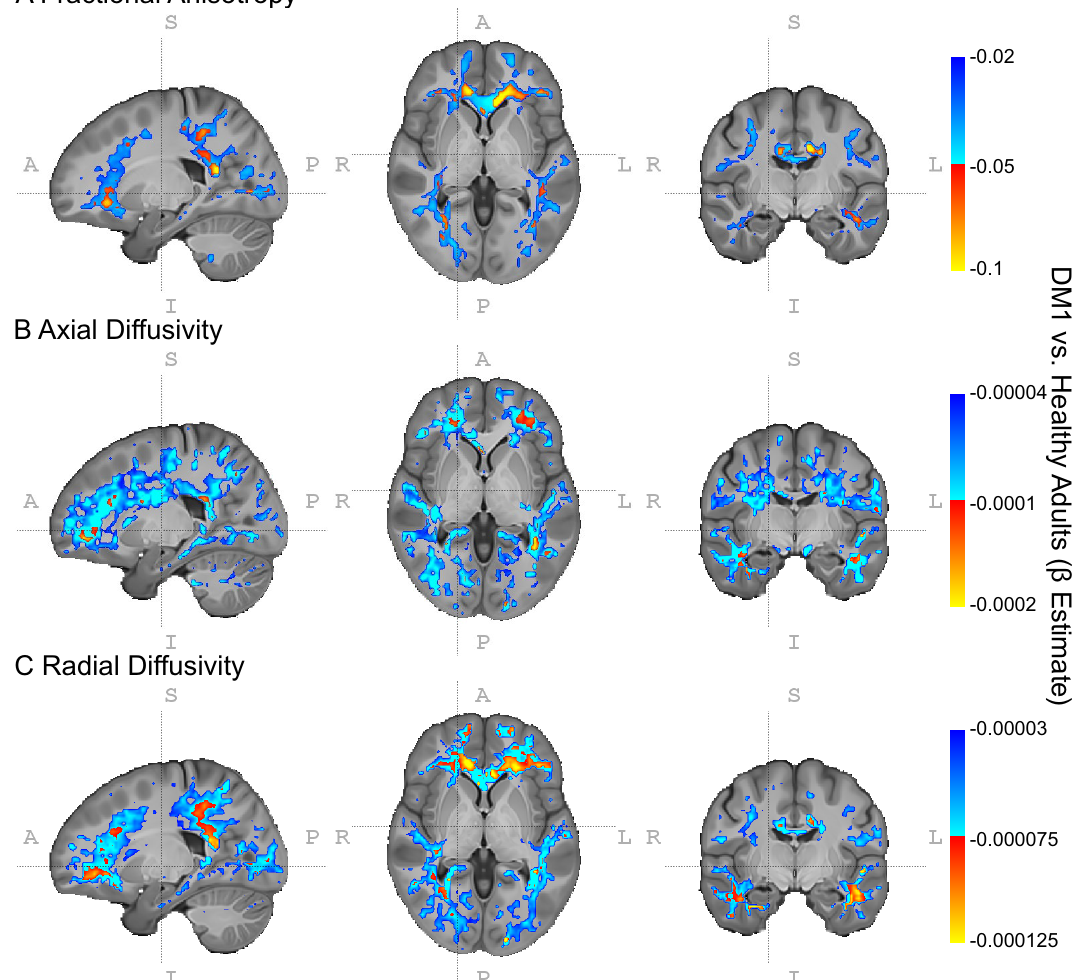
Figure 2. Voxelwise Group Differences in WM microstructure in DM1. WM microstructure in DM1 relative to healthy adults is characterized by decreased fractional anisotropy (panel A ), and increased axial (panel B ) and radial diffusivity (panel C ). This decreased WM integrity in DM1 appears to be systemic rather than regionally specific, though the size of effects varies. Cold colors indicate beta estimates for the group comparison in LME models thresholded at p uncorrected < 0.05; hot colors indicate estimates thresholded at p uncorrected < 0.01. Neuroimages were created using ITK-SNAP (version 3.8.0, http://www.itksn ap.org/) 26 . Inkscape (version 0.1, https ://inksc ape.org/) was used to add labels and color bars to the